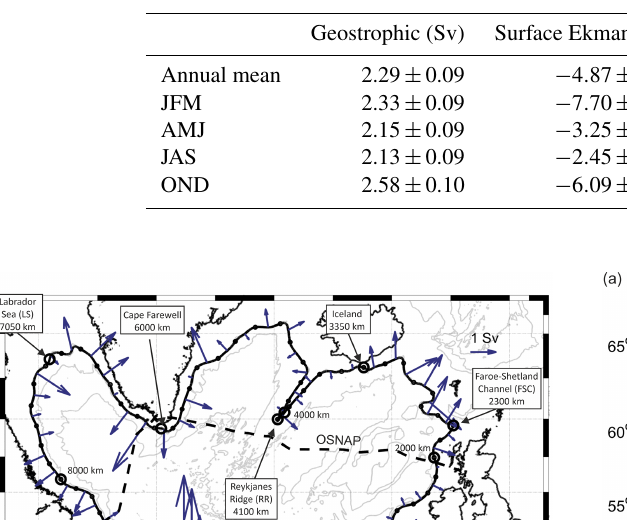
Table 1. Net transports into SPG above 1000m (in Sv).